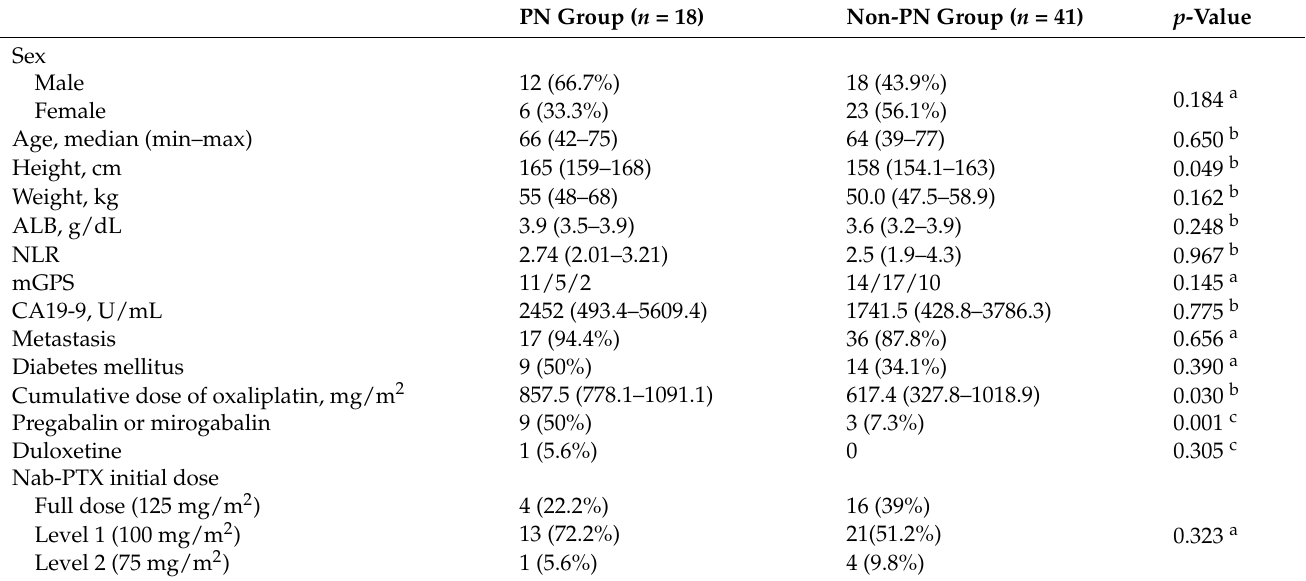
Table 1. Demographics and baseline characteristics of patients in the PN and non-PN group at the start of GnP.